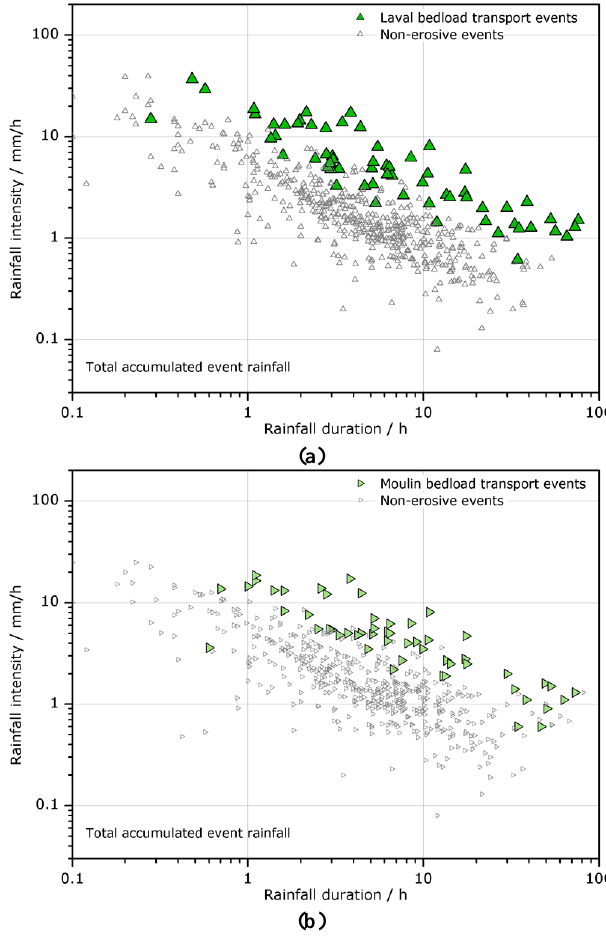
Fig. 5. (a) Intensity–duration relationship I T – D T for rainfall (recorded for the entire event) that triggered bedload transport in the Laval catchment (Draix site). (b) Intensity–duration relationship I T – D T for rainfall that triggered bedload transport in the Moulin catchment (Draix site). Non-erosive events are marked by small grey triangles in (a) and (b)